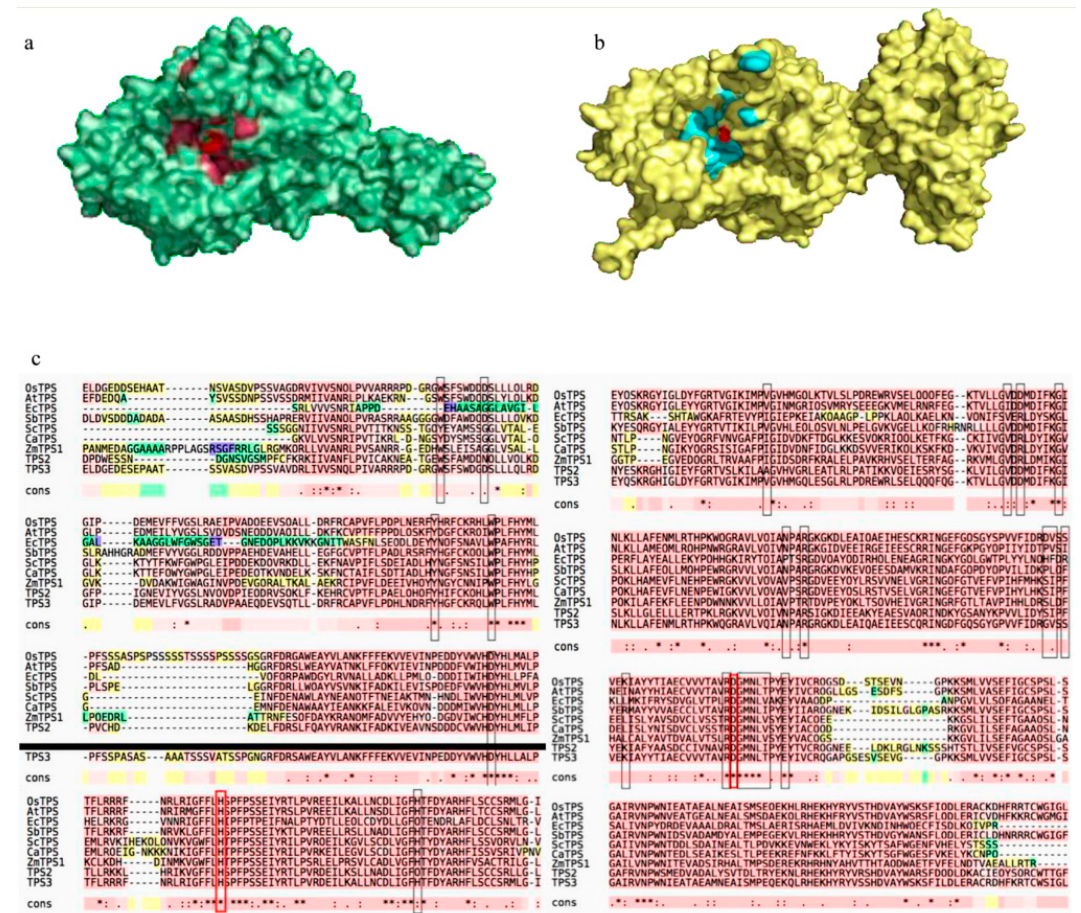
Figure 3. In silico analysis of TPS catalytic sites: ( a ) TPS-2 protein model with the catalytic sites; ( b ) TPS-3 protein with the location of the active site; ( c ) Multiple alignments of TPS-2 and TPS-3 amino acid sequences and functional TPS proteins from other species.